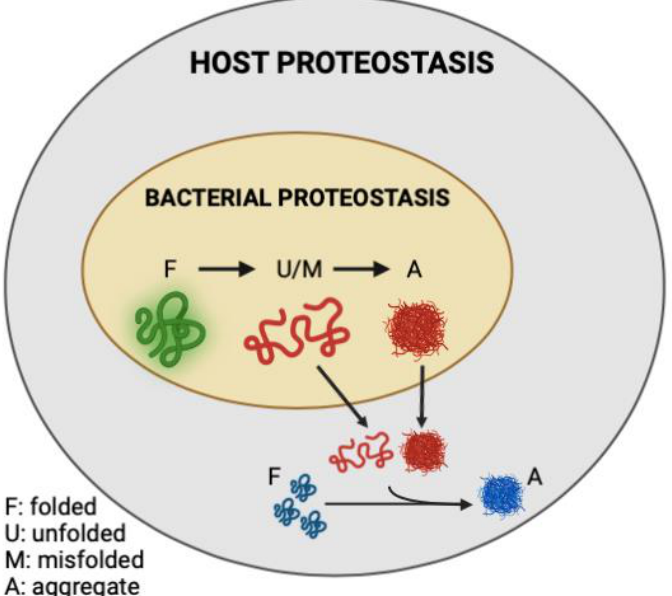
Figure 6. Model figure demonstrating the contribution of misfolded and aggregation-prone bacterial proteins to the disruption of host proteostasis.